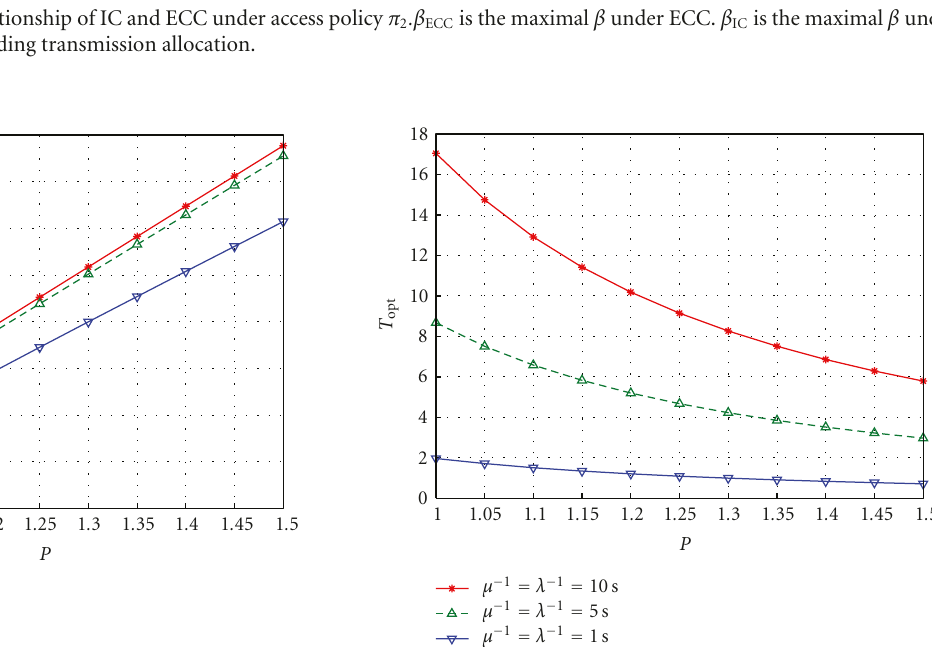
Figure 4: The optimal ρ 0,opt versus P for di ff erent holding times. Figure 5: The optimal T opt versus P for di